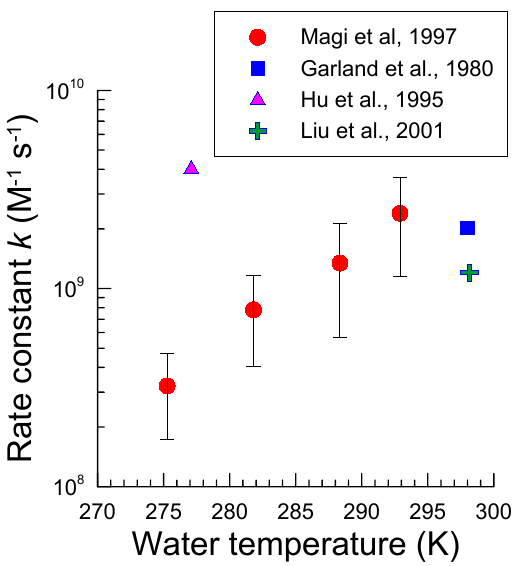
Figure 4. The second-order rate coefficient ( k) for the ozone–iodide reaction as a function of water temperature. Data from various stud- ies are shown.